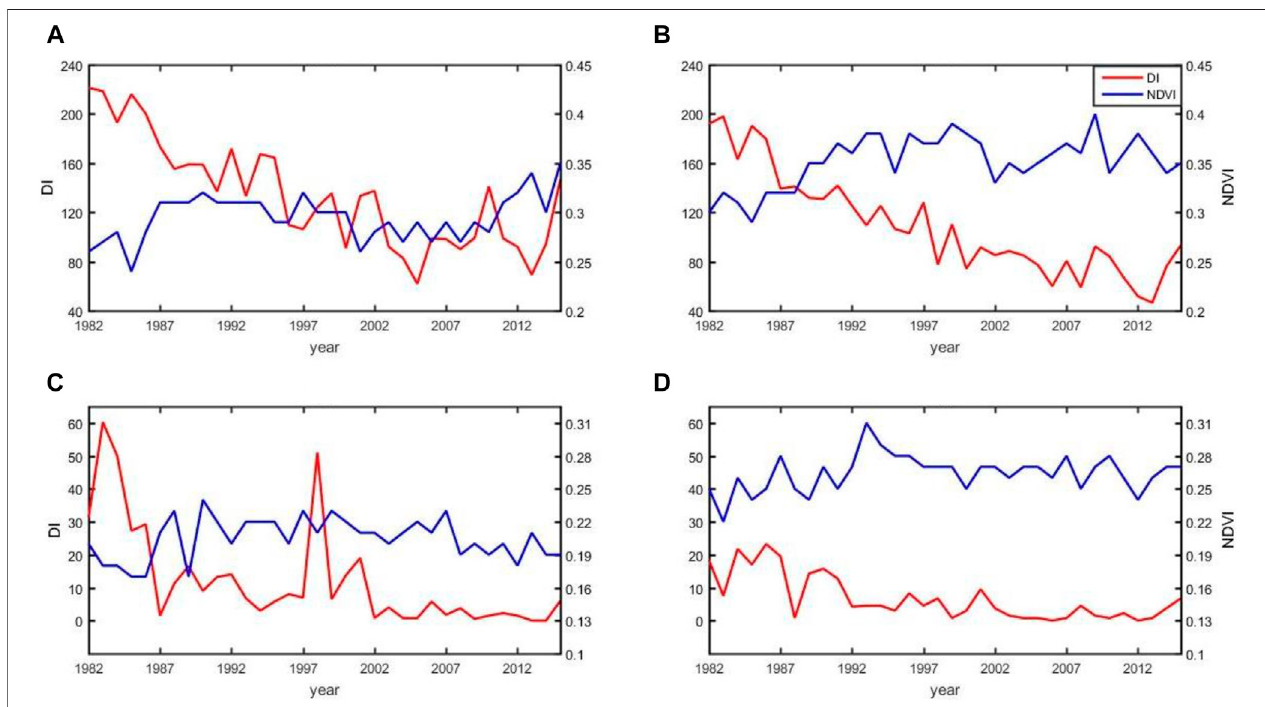
FIGURE 10 | Variations of DI and NDVI of Southern Xinjiang (A,B) and Northern Xinjiang (C,D) in spring (A,C) and summer (B,D) .